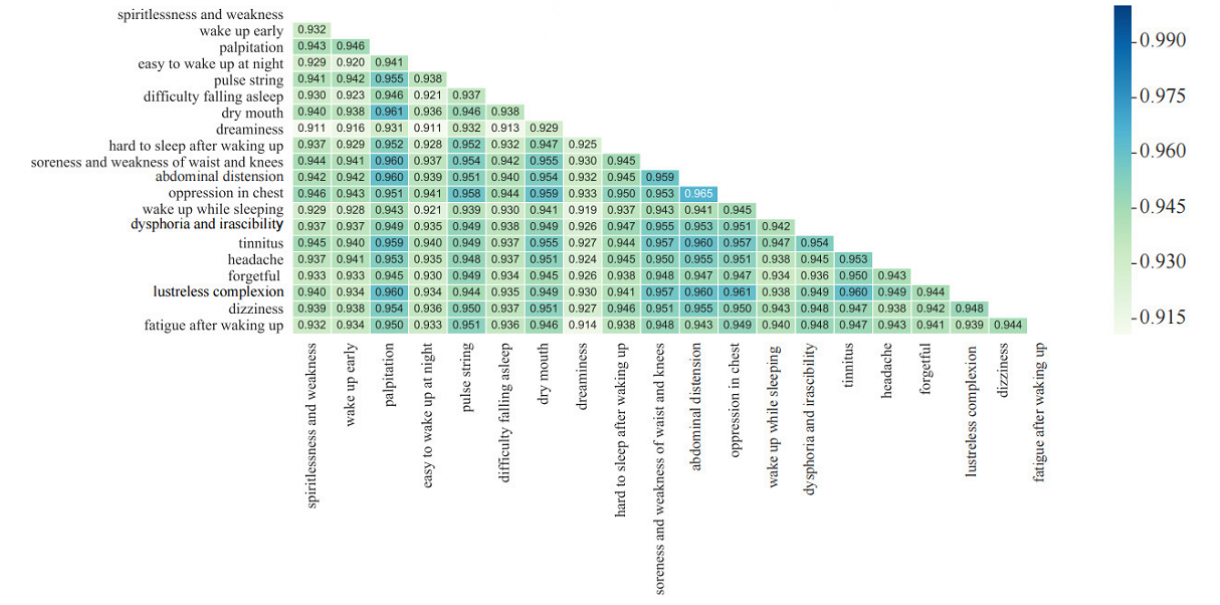
Figure 3. Pearson correlation coefficients between any two symptoms.